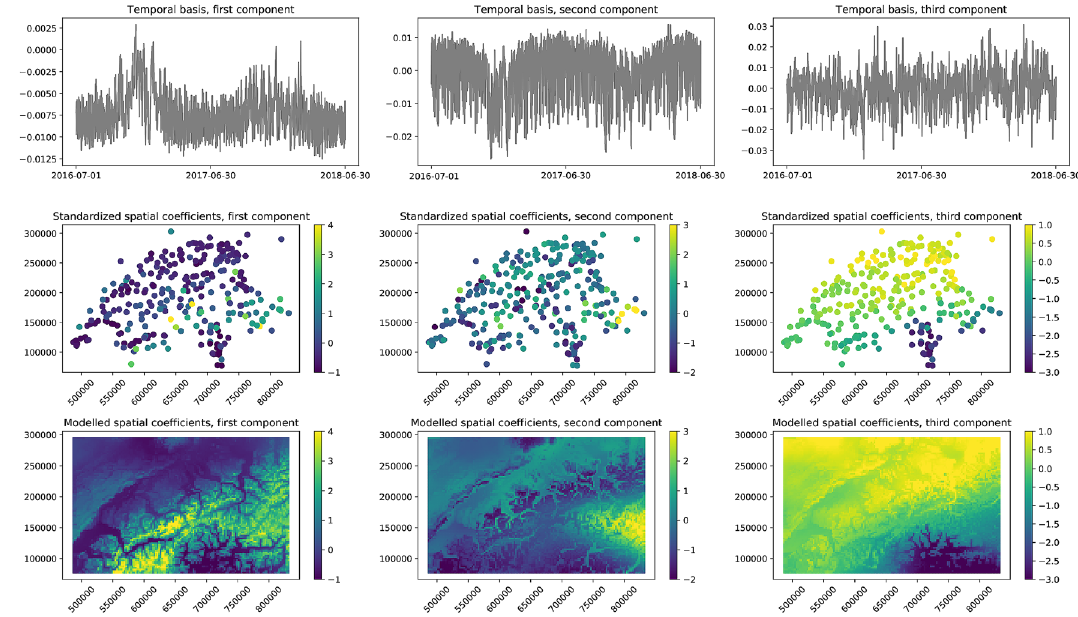
Figure 5. Temperature monitoring network, first 3 components of the EOFs decomposition. Top row : The temporally referenced basis functions. Center row : The normalized spatial coefficients of the corresponding EOFs. Bottom row: The corresponding predicted spatial coefficients provided by the auxiliary outputs of the fully connected neural network (all components).